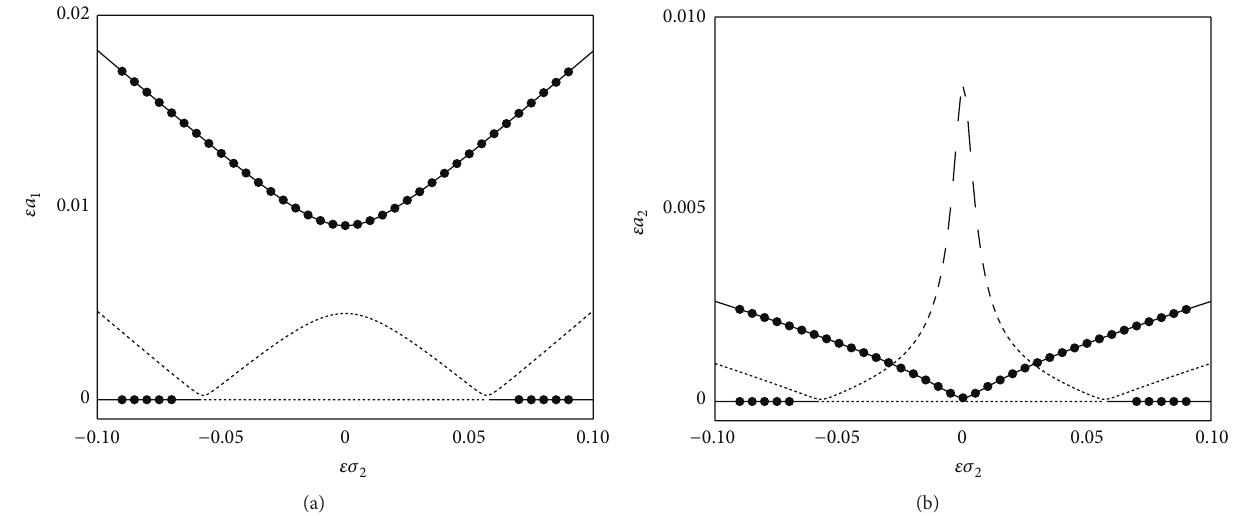
Figure 20: Comparisons in the summation resonance: (a) the first mode and (b) the second mode.